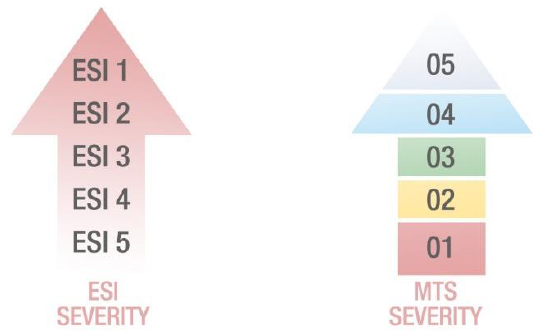
Figure 2. ESI & MTS Triage Systems.